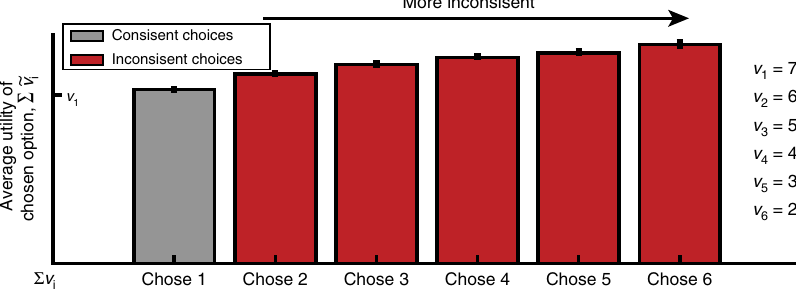
Fig. 7 The neural random utility model with six alternatives. The alternatives are ranked in value ( v 1 = 7, … , v 6 = 2) with the highest valued alternative termed the consistent choice. For inconsistent choices, the average utility of the chosen option increases as worse alternatives are chosen. This is because the random term, e i , had to be much larger (e.g., compare Chose 6 vs. Chose 2). Error bars indicate standard errors